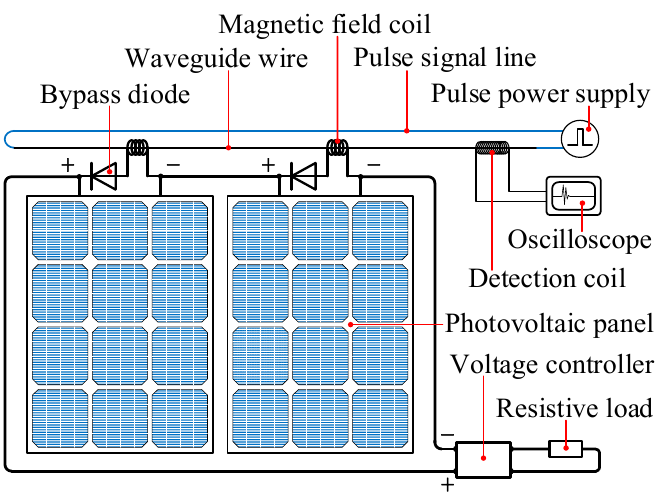
Figure 9. The relationship between each piece of experimental equipment. The process of the whole detection method is shown in Figure 10. Apply shading Pulse power supply conditions to an individual PV panel Photovoltaic string Corresponding bypass diode is in the on state Magnetic field coil is in the on state Axial magnetic field Torsional magnetic field Waveguide wire Torque wave Detection coilgenerate act on generate Oscilloscope Generate echoes ?Voltage controller No